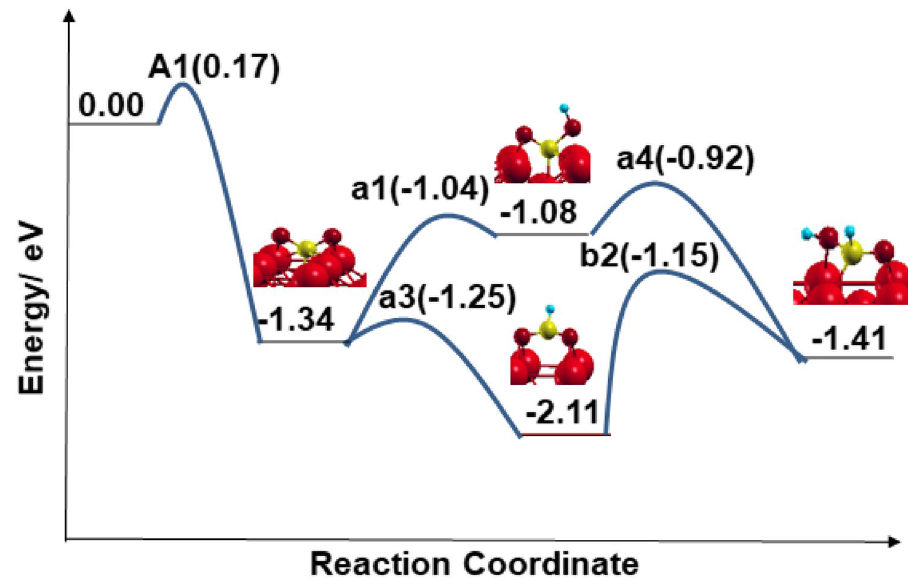
Fig. 6 Energy profile diagram for the conversion of CO 2 into formic